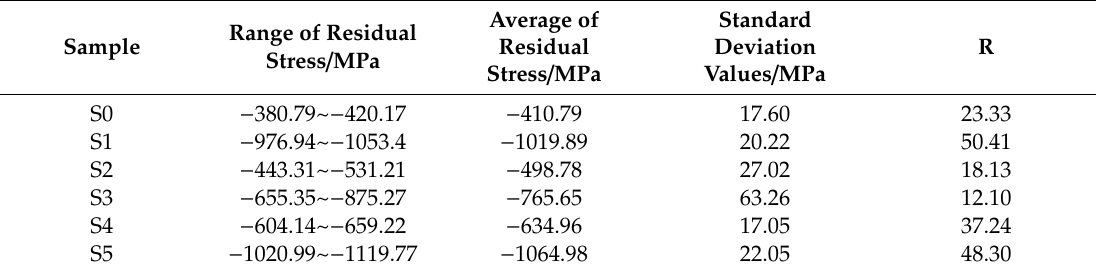
Figure 3. Residual stress distribution on the surface of Sample S3 after AWJP treatments. Table 4. Distribution of surface residual stress of 18CrNiMo7-6 steel after AWJP treatments.